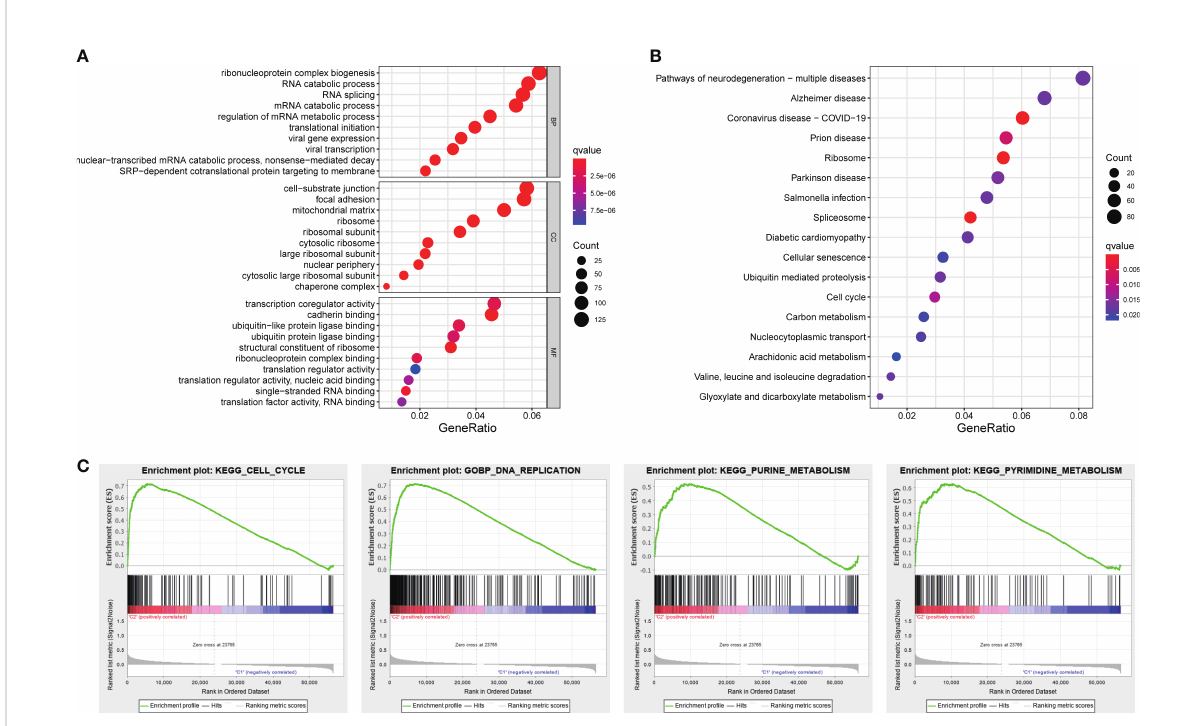
FIGURE 8 Functional analyses. (A) GO and (B) KEGG pathways enrichment analysis. (C) The GSEA